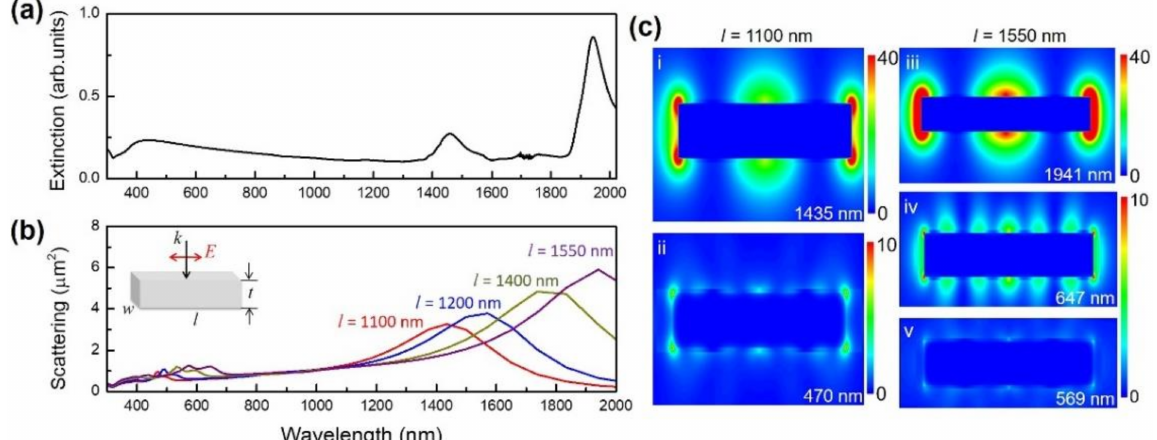
Figure 2. The localized surface plasmon resonance (LSPR) properties of a large-size Ag nanobar. ( a ) The experimental extinction spectrum taken from aqueous suspension of silver nanobars with vari- ous sizes. ( b ) The simulated scattering cross-section of two large-size silver nanobars ( w = t = 200 nm, l = 1100 nm, 1200 nm, 1400 nm and 1550 nm, respectively) at an incident angle ( θ = 0 ◦ ) in air (RI = 1.0). ( c ) The corresponding electric field distributions for a nanobar ( w = t = 200 nm) with two different lengths at on-resonance wavelengths (i) l = 1100 nm, λ res = 1435 nm, (ii) l = 1100 nm, λ res = 470 nm, (iii) l = 1550 nm, λ res = 1941 nm, (iv) l = 1550 nm, λ res = 647 nm, and (v) l = 1550 nm, λ res = 569